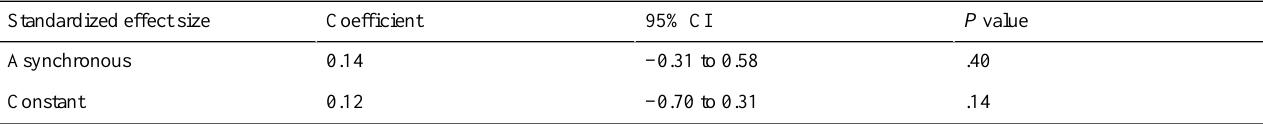
Table 4. Metaregression of synchronous and asynchronous interventions on quality of life outcome, analyzed using standardized effect size (postintervention mean and SD change